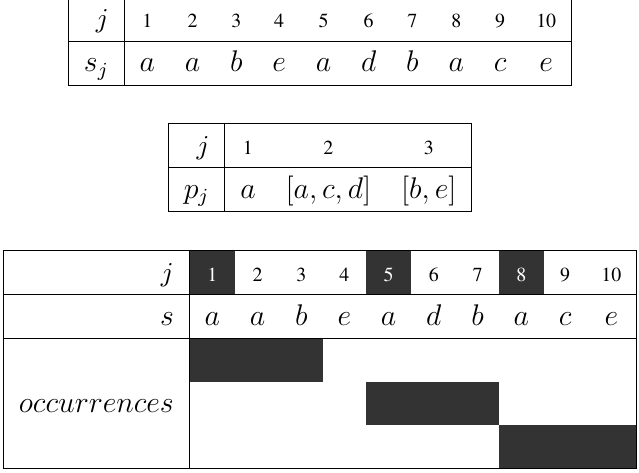
Table 2. Example of pattern. The occurrences of p in s are drawn in black.